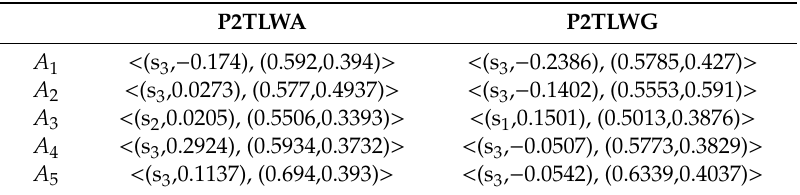
Table 21. Aggregating result of the P2TLWA / P2TLWG operator.